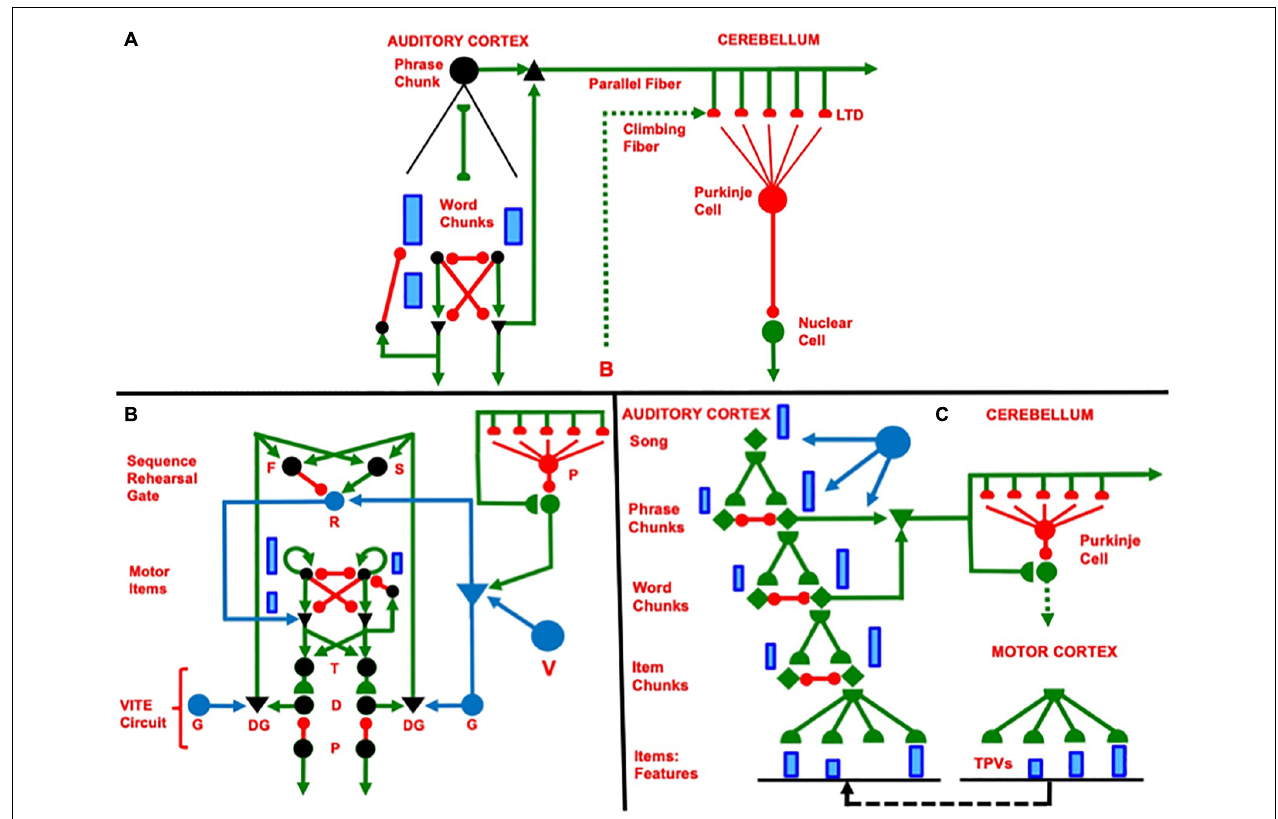
FIGURE 13 | (A) Sequences of Word Chunks that are stored in working memory in the auditory cortex interact via adaptive bottom-up and top-down pathways in an ART circuit to learn Phrase Chunks. Each Phrase Chunk emits parallel pathways to polyvalent cells. Each polyvalent cell also receives a specific input from a particular Word Chunk. This polyvalent cell thus responds selectively to its Word Chunk when it is currently being performed as part of a prescribed phrase of lyrics. The polyvalent cell activates parallel fibers to the cerebellum where they learn an adaptively timed duration to perform that word in a lyric. Climbing fibers are teaching signals that drive adaptively timed learning using Long Term Depression, or LTD, in (parallel fiber)—(Purkinje cell) synapses. During such a trained duration, Purkinje cell outputs are depressed and their target subcortical nuclear cells are disinhibited. (B) Circuitry whereby cerebellar adaptive timing regulates the learned durations between successive words in a lyric. (C) Circuitry whereby cerebellar adaptive timing regulates timed performance by the hierarchy of processing stages in the auditory cortex that represent a song’s lyrics. See the text for